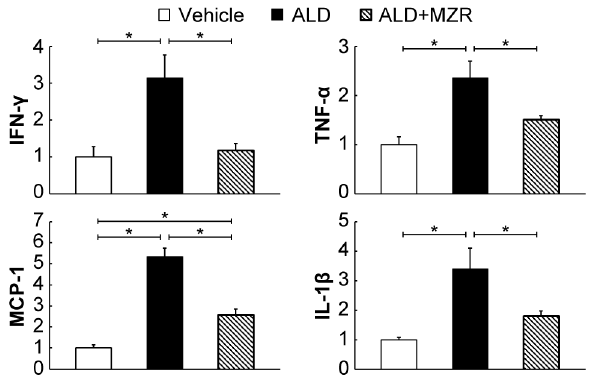
Figure 2. Mizoribine suppresses the renal expression of genes for various aldosterone-induced pro-inflammatory cytokines. Aldosterone (ALD) increased the renal cortical expression of genes for interferon (IFN)- c , tumor necrosis factor (TNF)- a , monocyte chemotactic protein (MCP)-1, and interleukin (IL)-1 b , against that of glyceraldehyde- 3-phosphate dehydrogenase (GAPDH). In contrast, the expression of these genes was suppressed by mizoribine (MZR). Values are presented as mean 6 SEM. * P , 0.05.